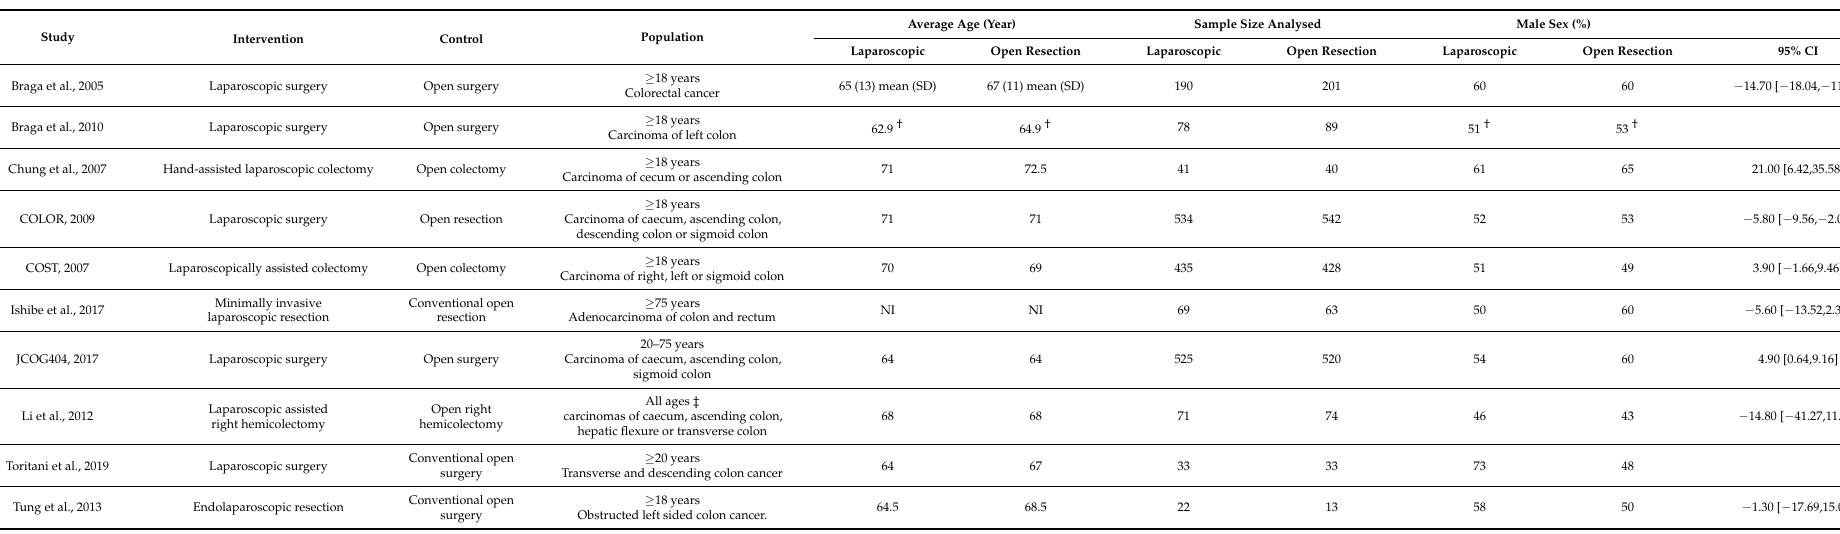
Data for colon and rectal cancer combined, as paper did not separate these two groups. † Data for cancer and non-cancer patients combined, as paper did non separate these two groups. ‡ Authors were contacted to confirm that all the participants were over 18 years old in accordance with the inclusion criteria of this review, refer to Table